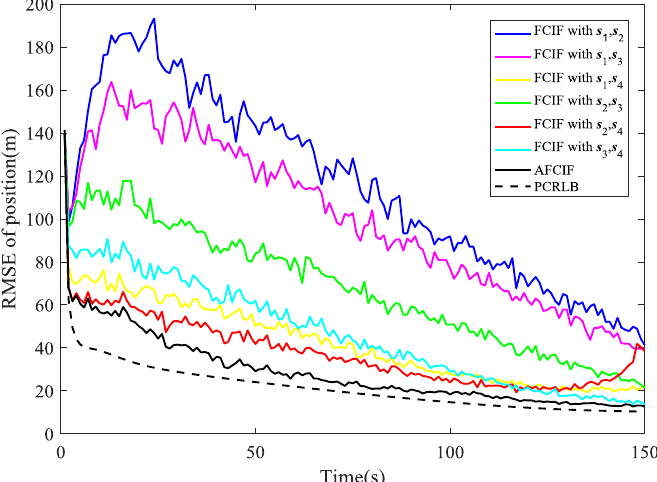
Figure 2. Comparison of RMSE (position estimation) when the initial process noise covariance is set to be larger than the true value.